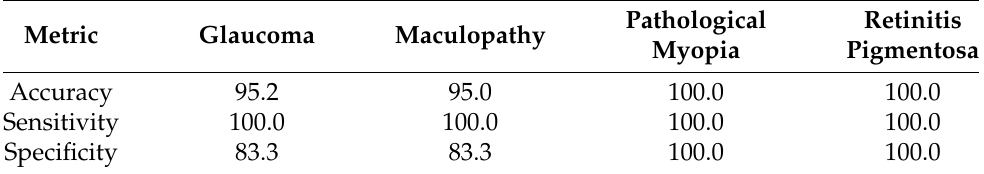
Table 2. Prediction results of the binary classifiers on test